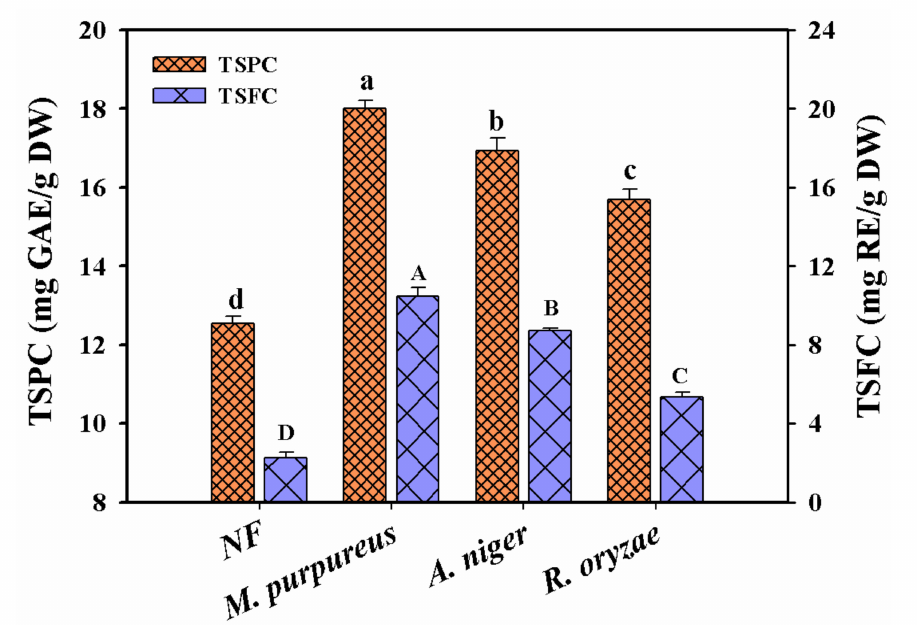
Figure 1. The contents of TSPC and TSFC in the fermented Chinese jujube by R. oryzae , A. niger and M. purpureus , respectively. Different superscripts (abcd/ABCD) indicated significant differences between samples at the different strains ( p < 0.05). NF represented the unfermented